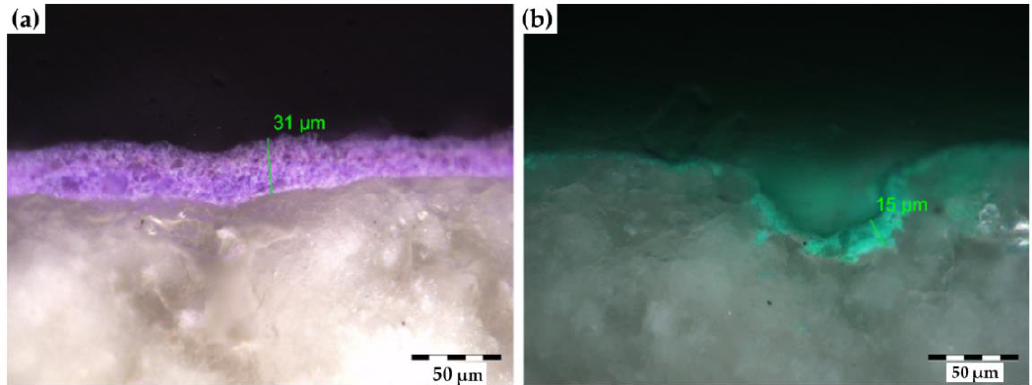
Figure 2. Micrographs taken with stereomicroscopy and scanning electron microscopy of stones painted with violet ( a , c , d : gneiss, b : travertine) and green ( e , g , h : gneiss, f : travertine) graffiti paints. EDX spectra of the paints are also shown.